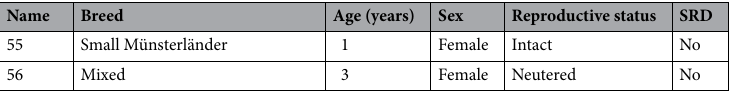
Table 3. The demographic data of the subjects who participated in the separation test (N = 56). These dogs were all included to the analysis as their owners also completed the questionnaire about them.